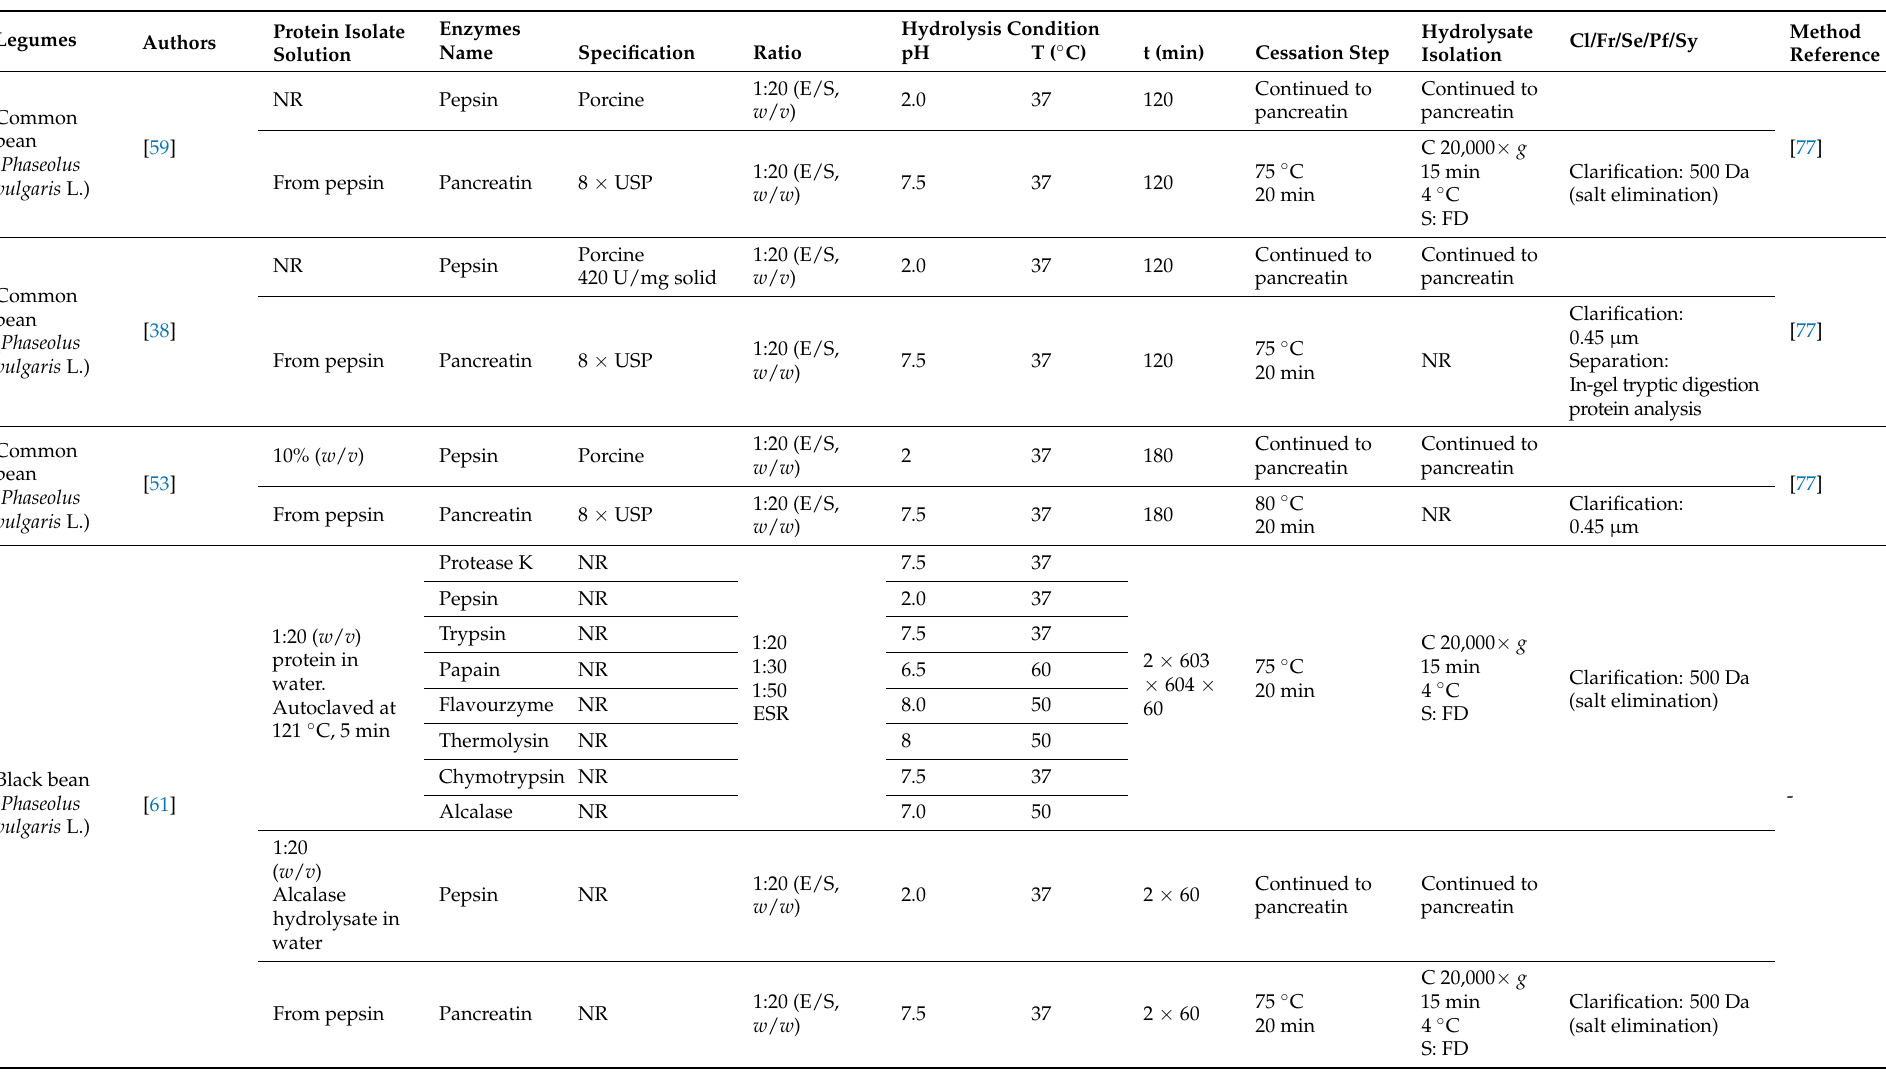
Table 3. Protein hydrolysis